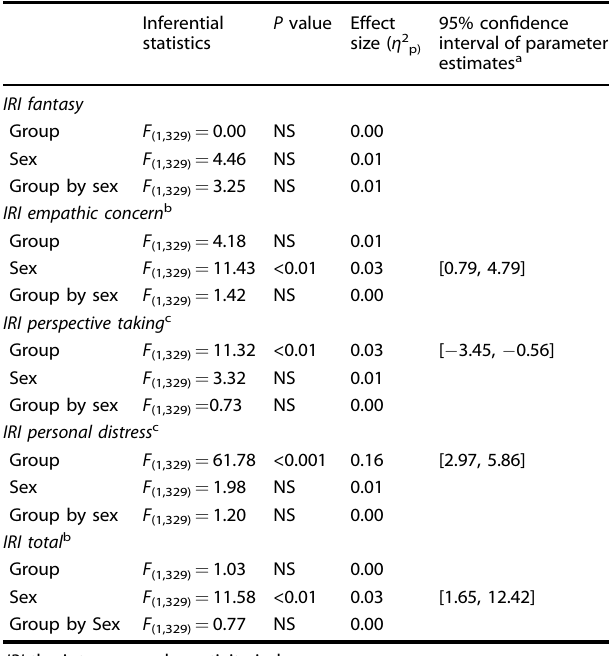
Table 3. Performance on subjective social cognitive measures.